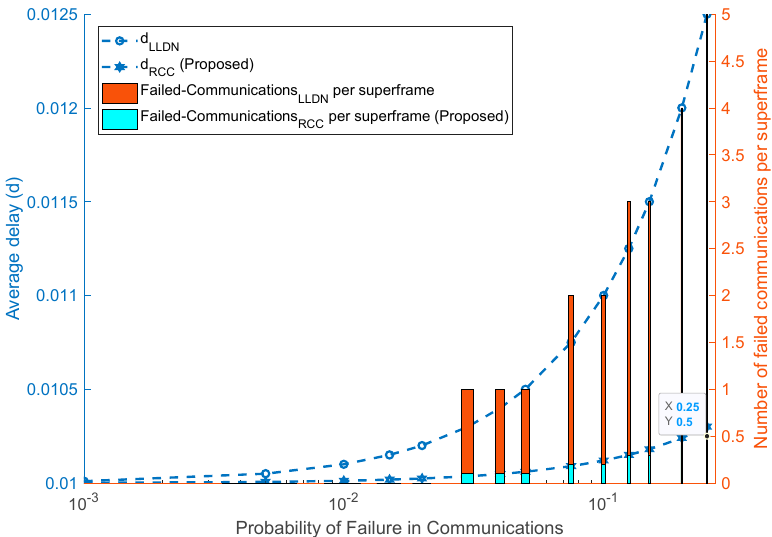
Figure 2. Average delay and communications reliability (RCC = 1, MCC = 3).